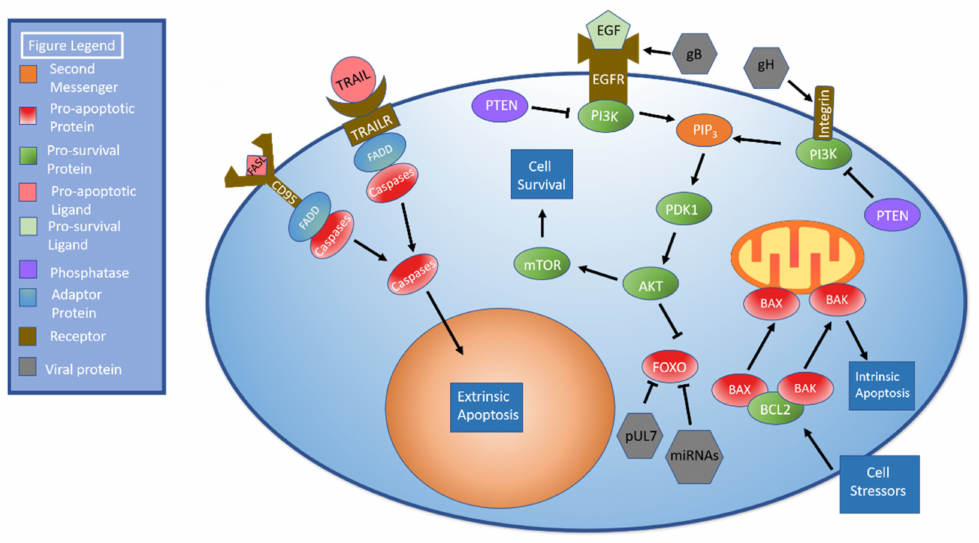
Figure 4. AKT and Apoptosis. There are two apoptotic pathways: extrinsic and intrinsic. The extrinsic pathway begins when ligands such as FAS ligand (FASL) or TRAIL bind their corresponding cellular receptors. The adaptor protein FADD is recruited to the receptor. FADD recruits procaspases to create the death-inducing signaling complex (DISC). Once DISC has formed, it facilitates autoproteolytic cleavage and caspase activation. Activated caspases cleave target molecules and stimulate apoptosis. The intrinsic pathway is initiated when the cell is exposed to stressors. The pro-apoptotic proteins BAK and BAX dissociate from BCL2 and disrupt the mitochondrial membrane, resulting in release of mitochondrial contents and apoptosis. The AKT pathway, which can be initiated through either EGFR or integrin stimulation, begins with receptor-mediated activation of PI3K. PI3K activation results in the formation of PIP 3 , which activates PDK1, which in turn activates AKT. AKT activates mTOR, which promotes cell survival. The human cytomegalovirus (HCMV) protein pUL7 and HCMV miRNAs inhibit FOXO. HCMV gB interacts with the EGFR while gH interacts with integrins to stimulate AKT.